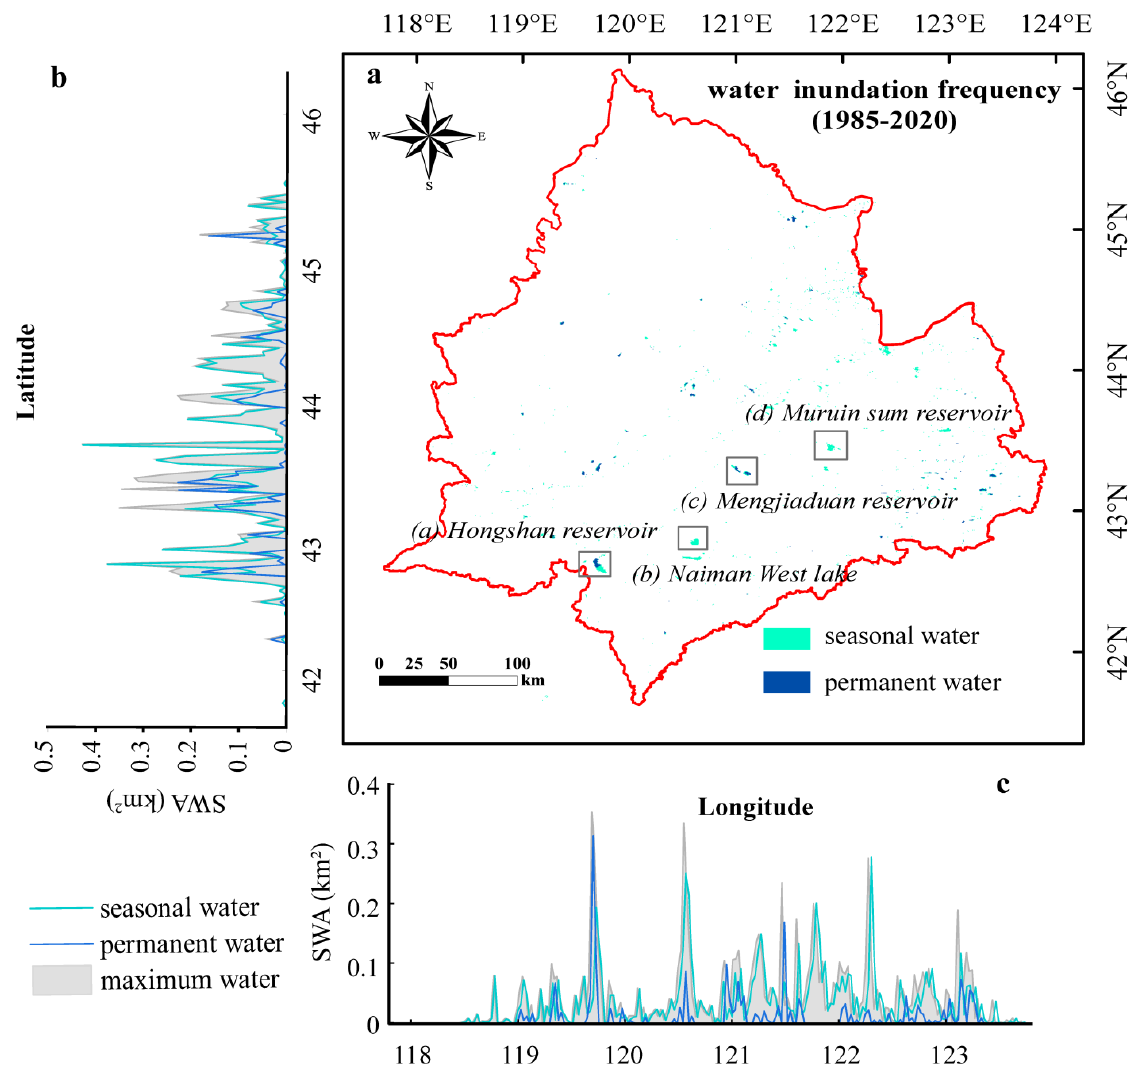
Figure 5. Water inundation frequency (seasonal water and permanent water) distribution map of 1985 – 2020 in HQSL ( a ); left ( b ) and underneath ( c ) the map are 0.25° latitude and longitude summaries of SWA.